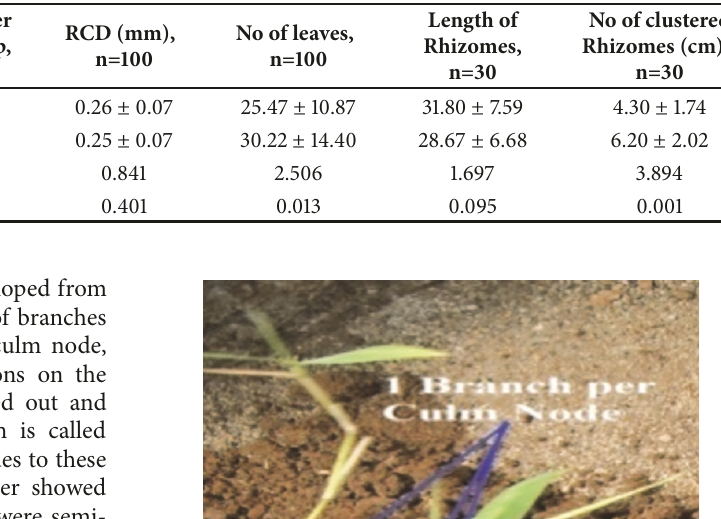
Table 3: Mean values of seedlings early growth performance parameters between two O. abyssinica provenances (n=30 or 100, mean ± standard deviation (SD)).